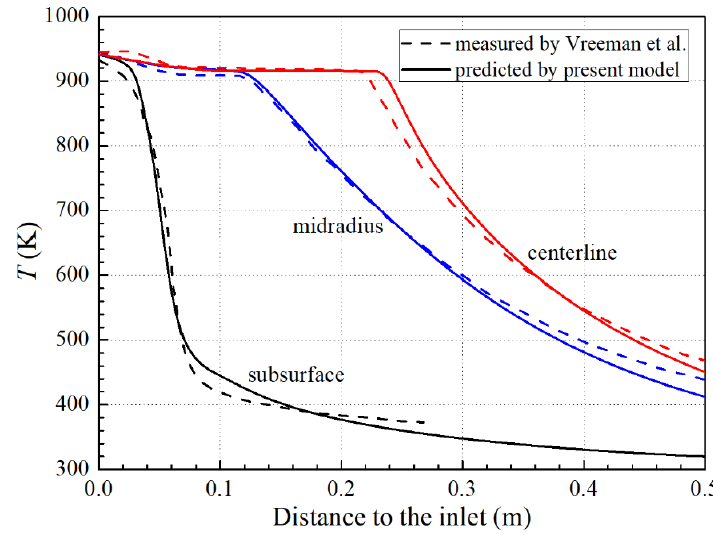
Figure 2. Comparison of the vertical temperature profiles predicted by present model and measured by Vreeman et al. [21] at three different radiuses in the grain-refined billet (case 1).